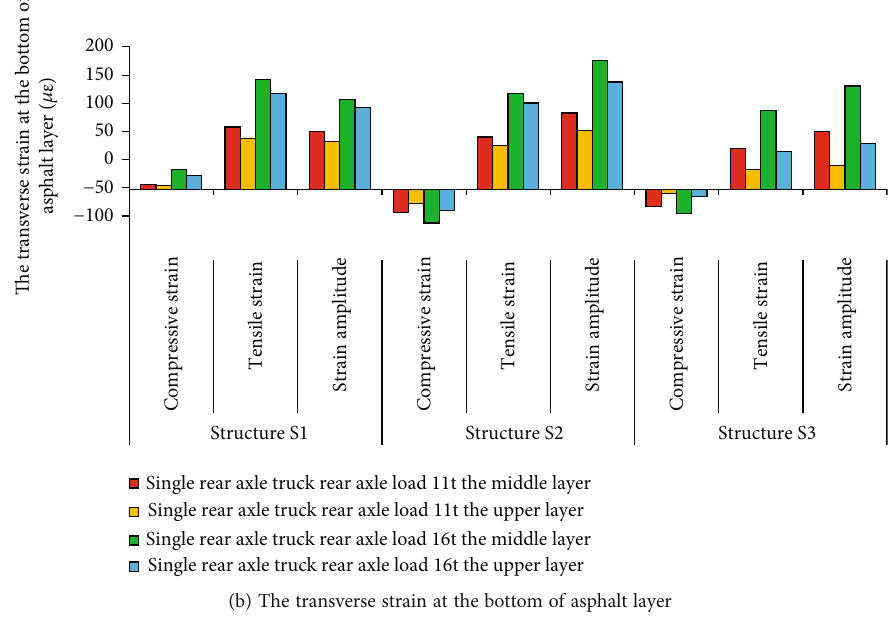
(a) The longitudinal strain at the bottom of asphalt layer